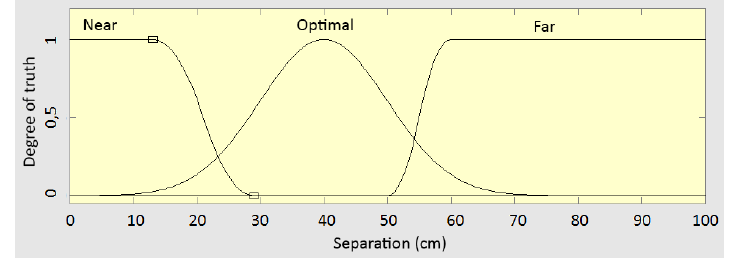
Figure 12. REMOVI distance control input membership functions.